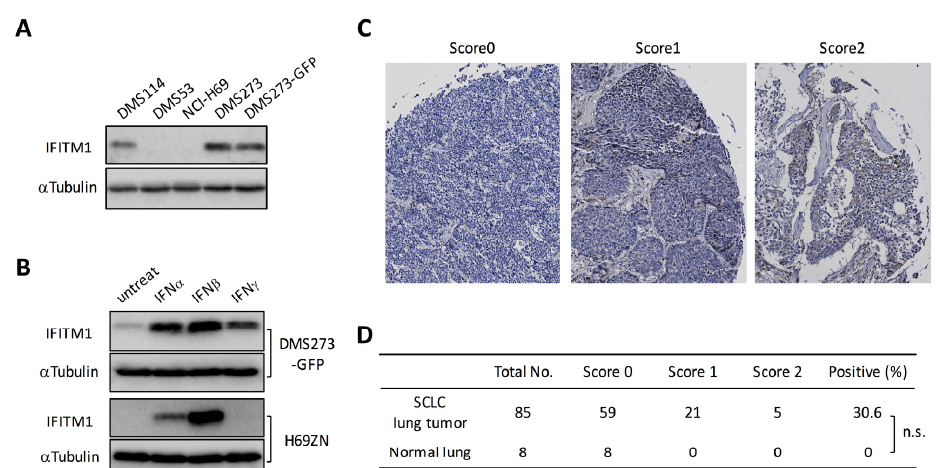
Figure 3. IFITM1 expression in human SCLC cell lines and lung tumor tissues from patients with SCLC. ( A ) Western blotting for IFITM1 in human SCLC cell lines. Whole-cell lysates (20 µ g) were separated by 15% SDS-PAGE, and membranes were blotted with anti-IFITM1 (top panel) and anti- α -tubulin antibodies (bottom panel, loading control). ( B ) Western blotting for IFITM1 in IFN-treated DMS273-GFP cells and H69ZN cells (a ZsGreen-labeled subline of NCI-H69 cells). Whole-cell lysates (20 µg) were separated by 15% SDS-PAGE. ( C ) Representative immunohistochemistry images of IFITM1 staining in lung tumor tissues from patients with SCLC on cancer tissue arrays. The images were taken at × 200 magnification. ( D ) Summary of the cancer tissue array analysis. The estimated visual intensity